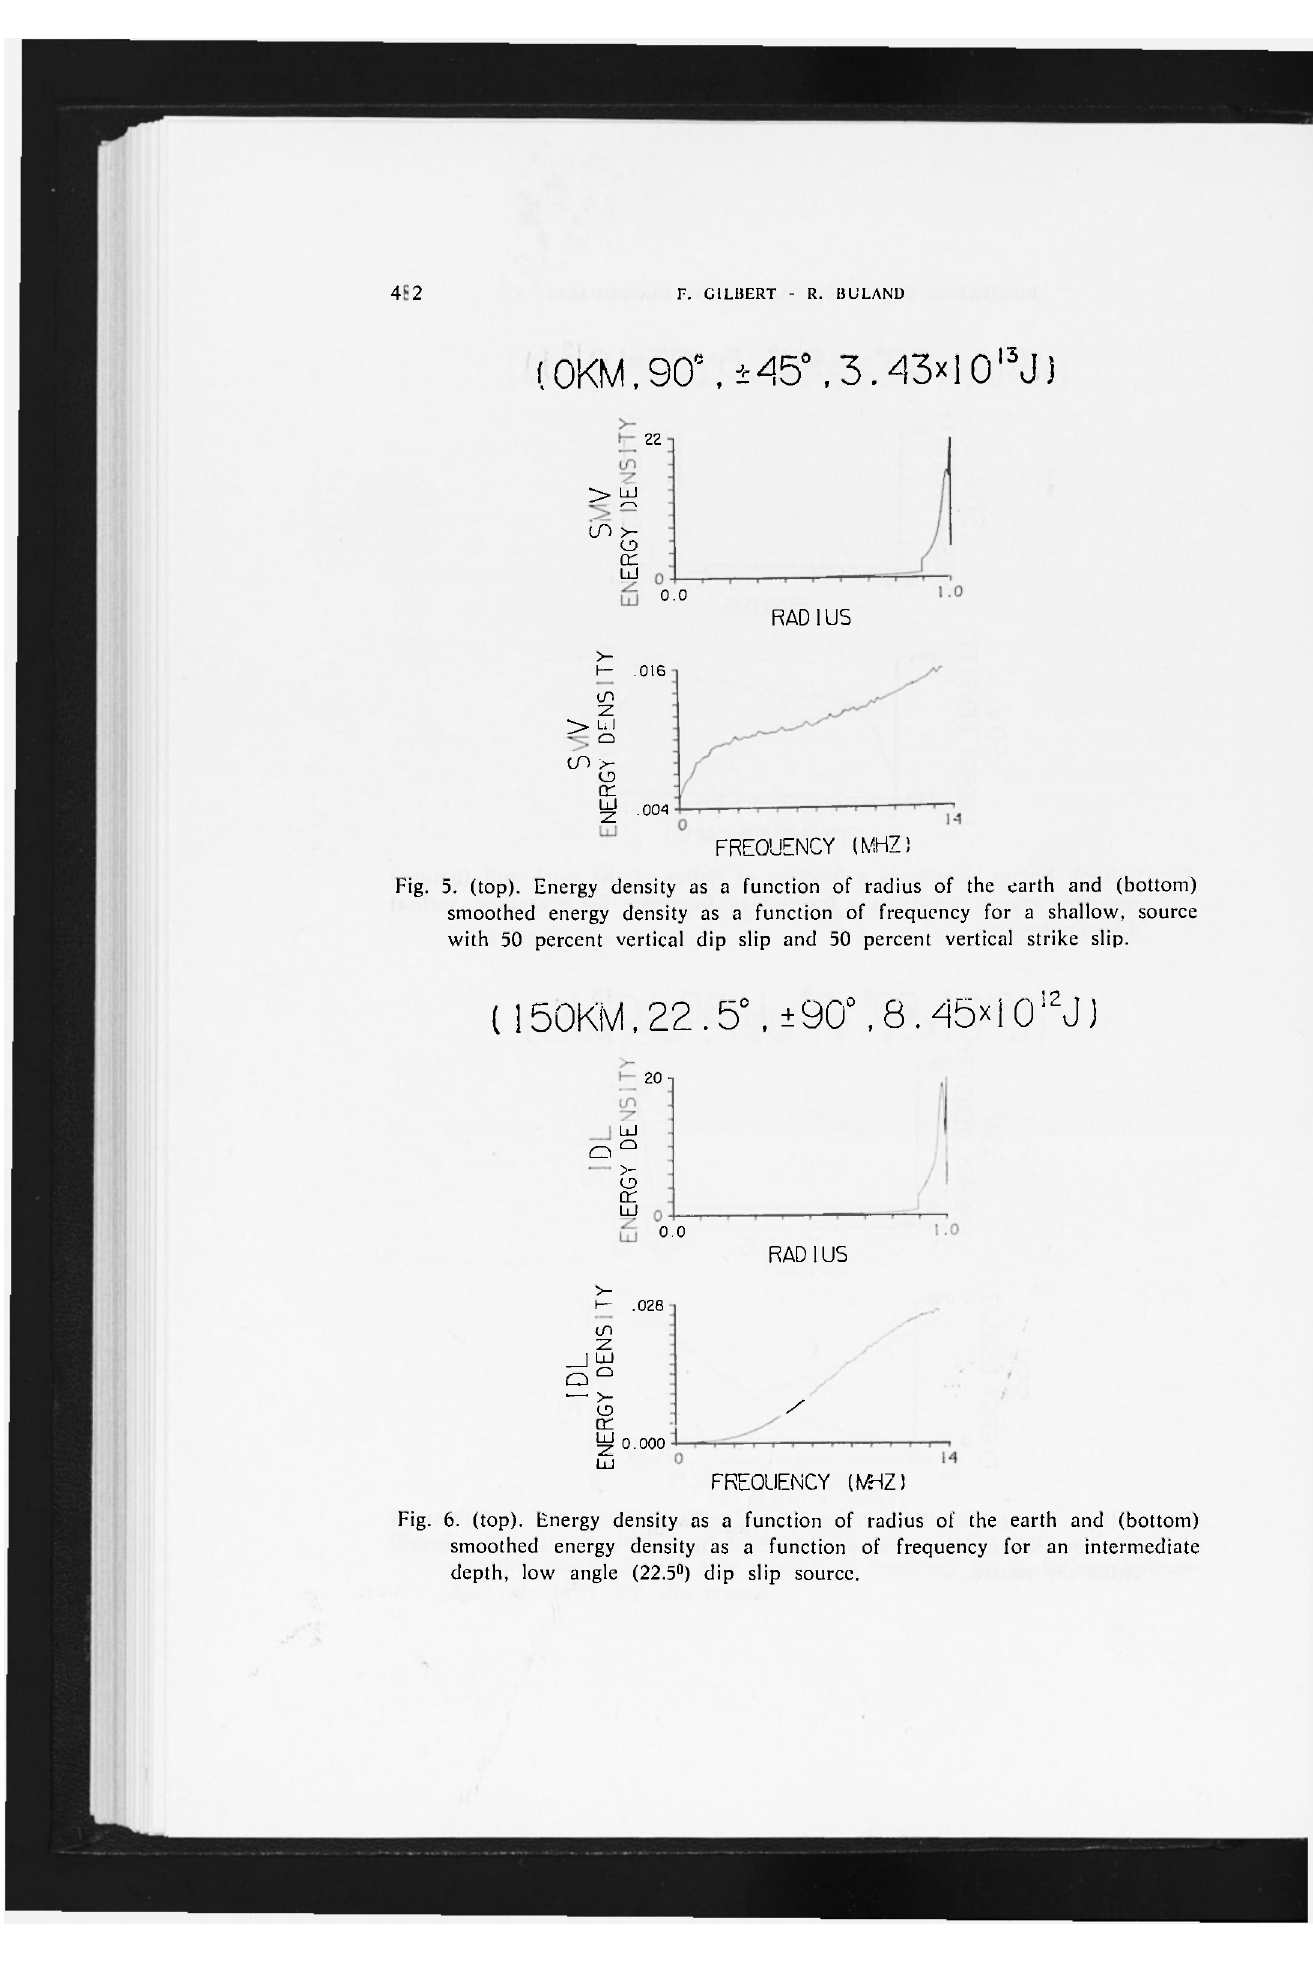
Fig. 6. (top). Energy density as a function of radius of the earth and (bottom) smoothed energy density as a function of frequency for an intermediate depth, low angle (22.5°) dip slip